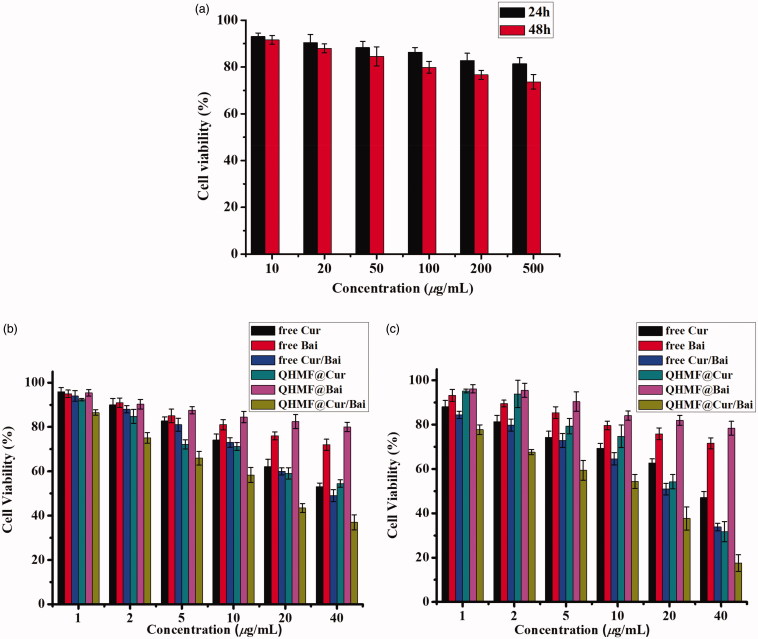
(a) Viability of A549 and RAW264.7 cells with QHMF at 24 and 48 h. The inhibiting effects of free Cur, free Bai, free Cur/Bai, QHMF@Cur, QHMF@Bai, and QHMF@Cur/Bai at 24 (b) and 48 h (c) on the A549 and RAW264.7 cells.